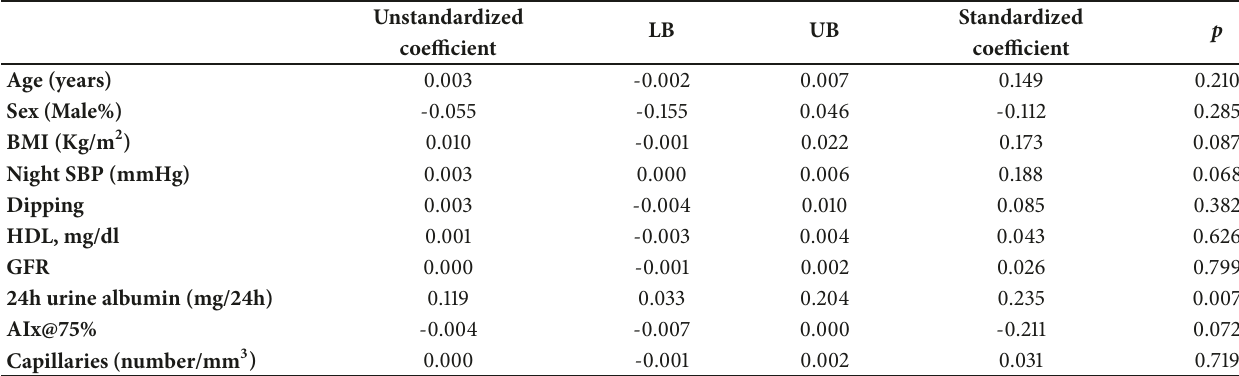
Table 3: Multiple linear regression models for factors predicting urinary sodium excretion 24h urine sodium (mmol/24h) (adjusted R square=0.168, R square=0.209, p <